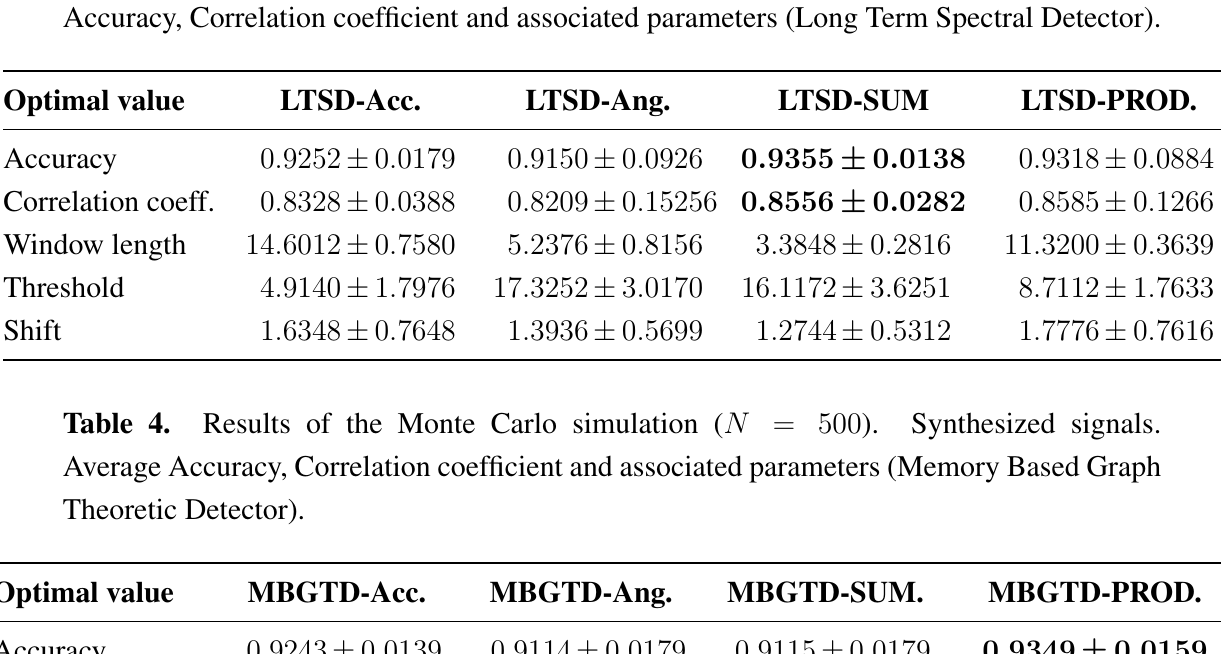
Table 3. Results of the Monte Carlo simulation ( N = 500 ). Synthesized signals. Average Accuracy, Correlation coefficient and associated parameters (Long Term Spectral Detector).